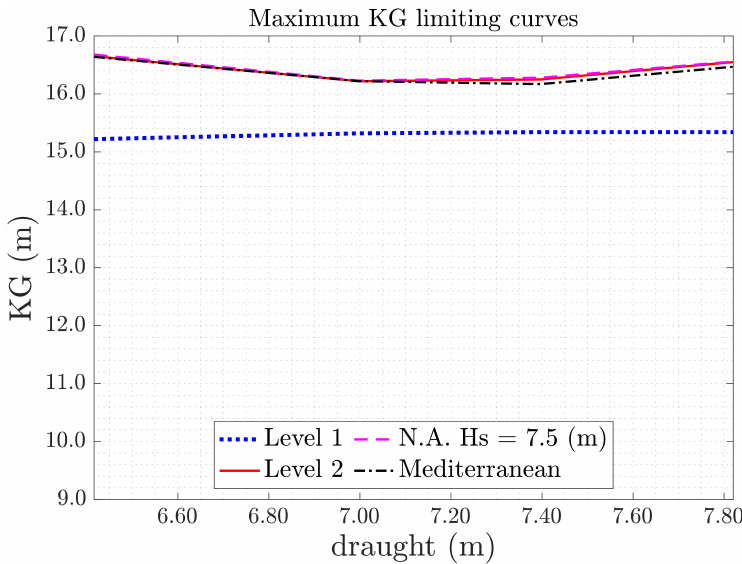
Figure 7. Vulnerability assessment in terms of maximum KG limiting curve for the dead ship failure mode. Curves obtained according to the results for the application of Level 1, Level 2, Level 2 for North Atlantic Ocean limited to H S = 7.5 ( m ) and Level 2 for Mediterranean.